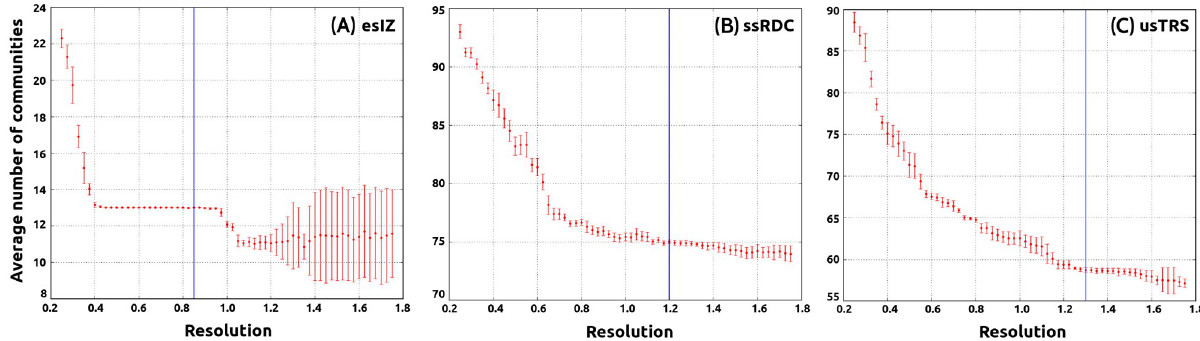
Fig 4. Louvain algorithm calibration. (A) Elementary school esIZ calibration, the optimal resolution value is 0.85. (B) Secondary school ssRDS calibration, the optimal resolution value is 1.20. (C) University usTRS calibration, the optimal resolution value is 1.30. Each value was obtained after 300